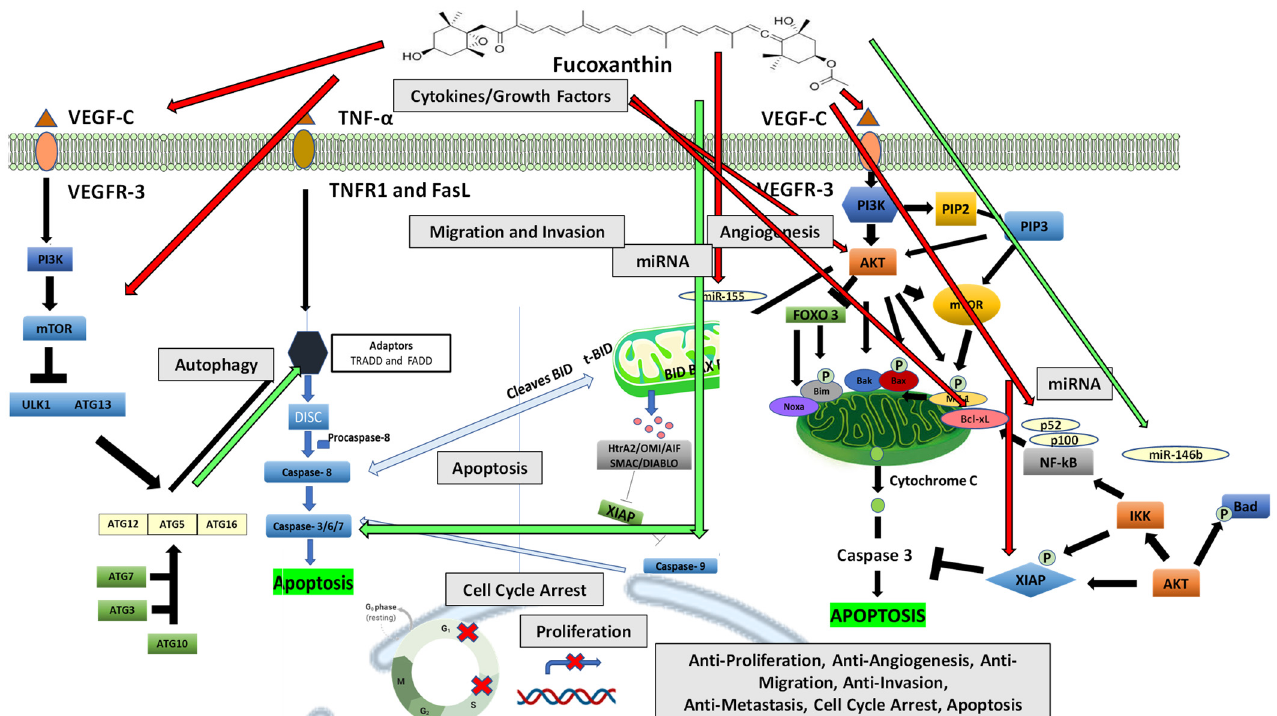
Figure 8. Proposed fucoxanthin action on cancer progression and development by modulating diverse signaling transduction pathways. Red arrows indicate that inhibition is induced by fucoxanthin, and green arrows indicate activation is induced by fucoxanthin.